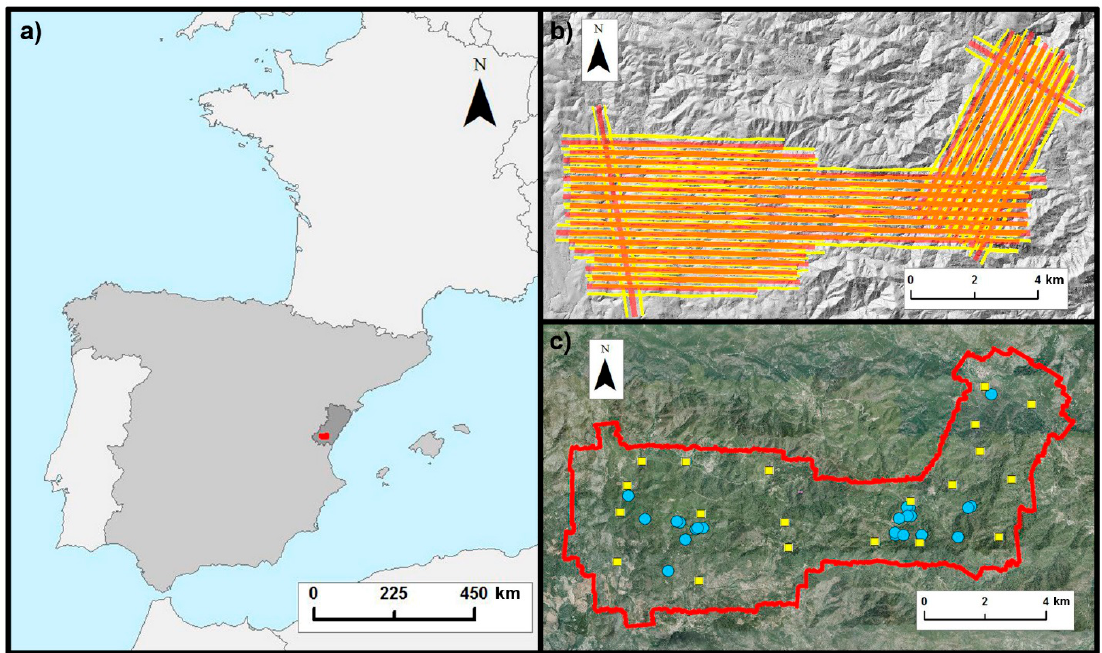
Figure 5. Maps of ( a ) the general location of the study area in Natural Park of Sierra de Espadán (Castellón, Spain), ( b ) flight stripes categorized by scan angle interval (0°–5° in orange and 15°–20° in yellow), and ( c ) sample locations (square samples for analyzing radiometric differences in RWE are represented in yellow, and circular samples for analyzing estimation of forest fuel variables are in blue).